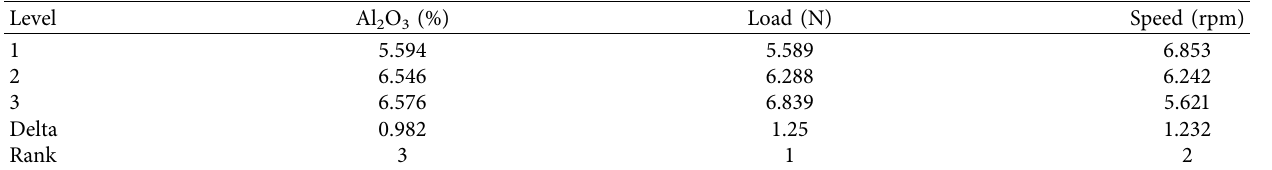
Figure 10: Coefcient of friction of epoxy hybrid composites at 60N load. Table 2: Response table for signal-to-noise ratios for coefcient of